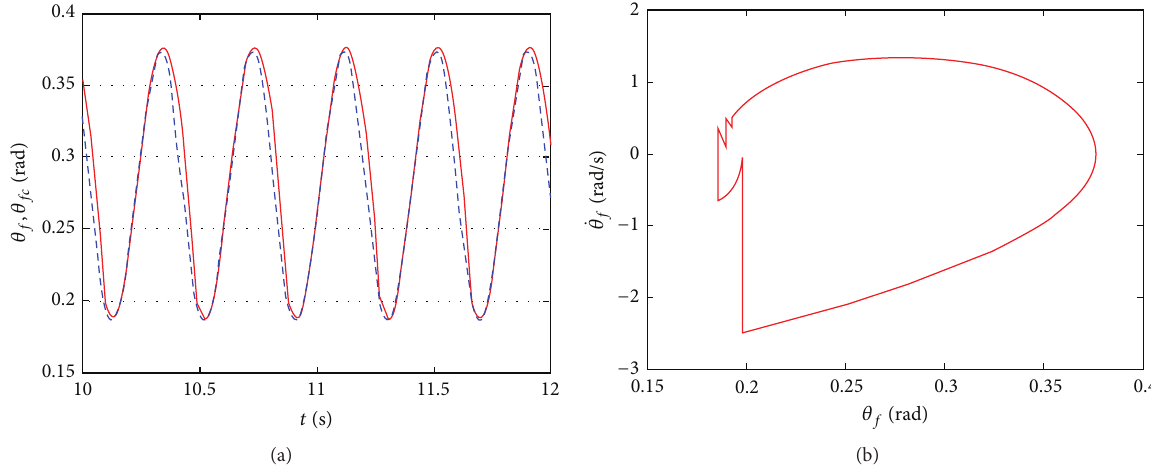
Figure 5: 𝑃(∞,1) motion when 𝜔 = 16 rad/s: (a) time history of 𝜃 𝑓 (solid line) and 𝜃 𝑓𝑐 (dashed line) and (b) phase diagram.